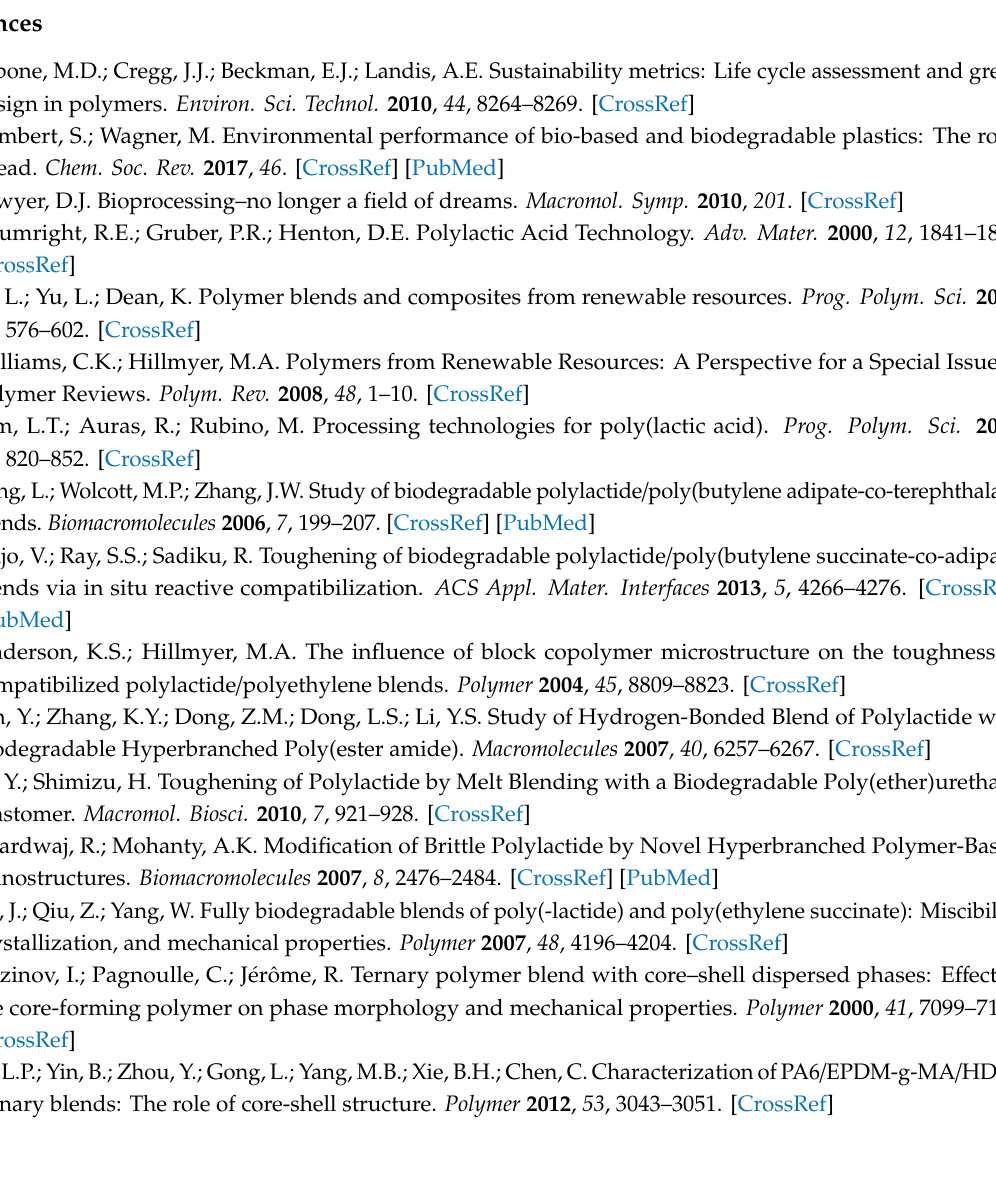
Figure S1: Tensile stress-strain curves of the neat PLA, PLA / PCL and PLA / PCL / EMA-GMA blends, Figure S2: Stress-strain curves of all the 5 samples of PLA / PCL